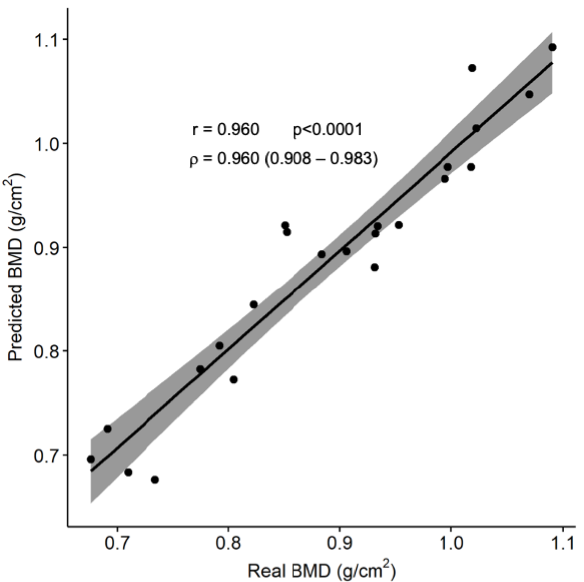
Figure 2. Comparison between the predicted and actual subtotal BMD. The solid line represents the regression function between the variables, while the gray area shows its 95% confidence interval. Abbreviation: BMD: bone mineral density.